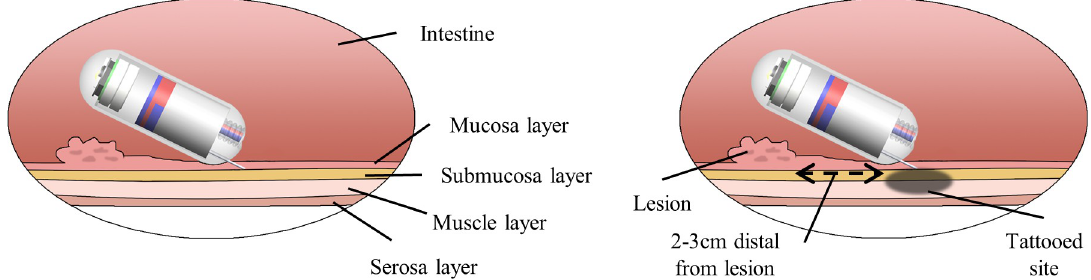
Fig 1. Recommended tattooing position. The right figure shows the injection in the submucosal layer with an oblique angle to the organ’s wall, and the left figure shows the injection location relative to the lesion margin.